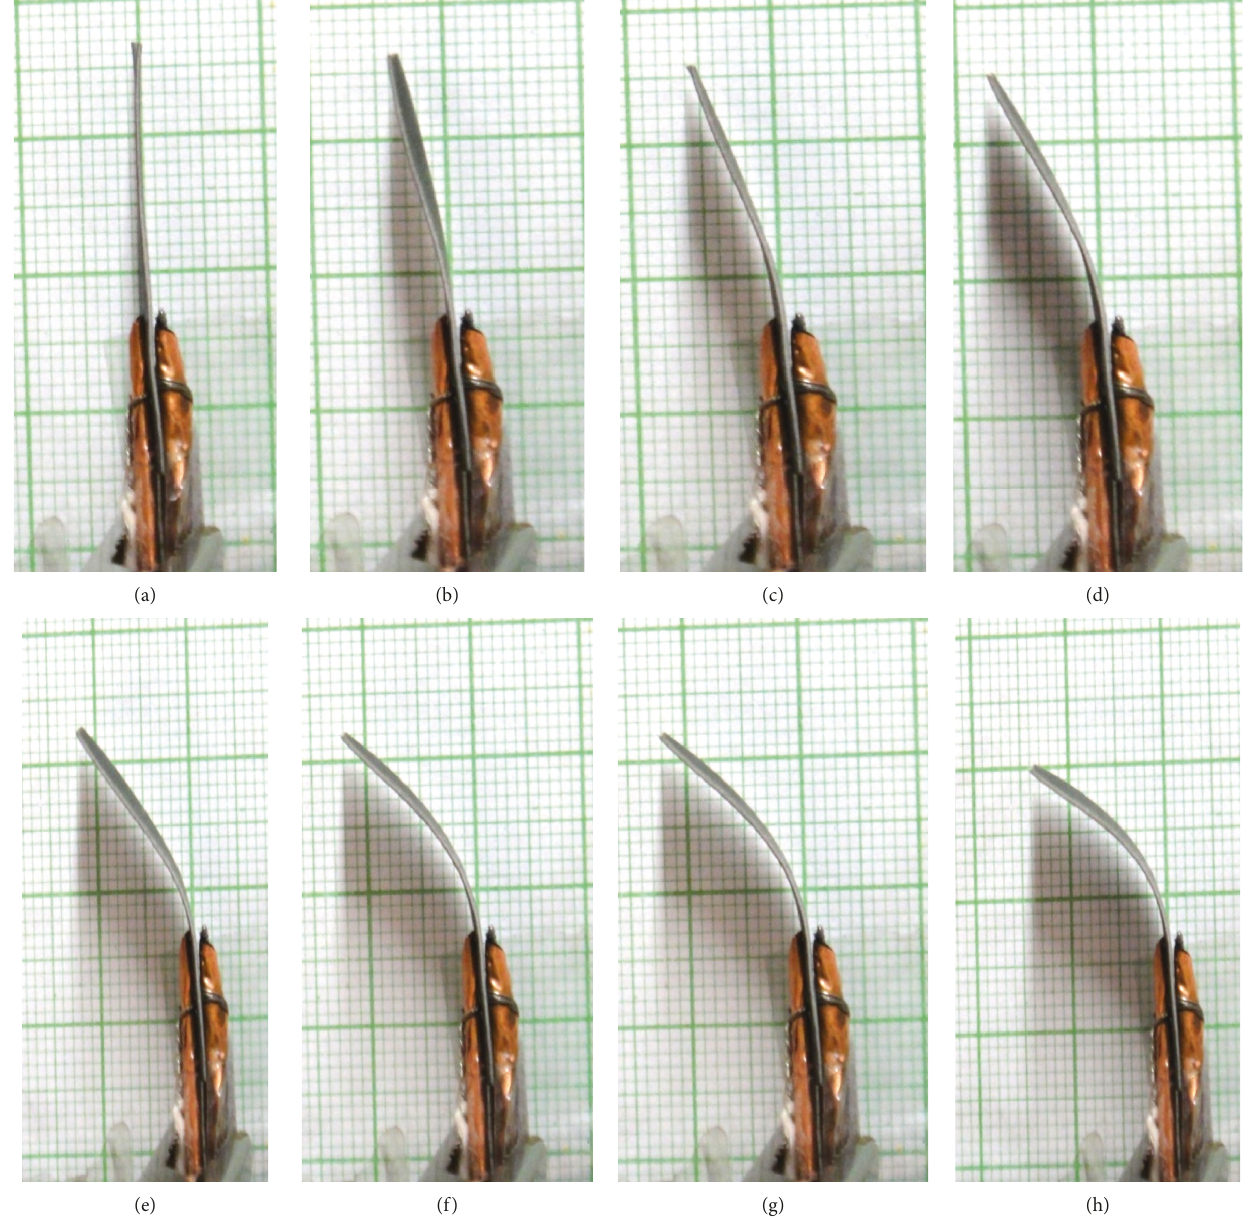
Figure 12: Experimental deflection response of PANI/PVC-PEDOT: PSS-ZrP at different voltages (0–3.5V): (a) 0V, (b) 0.5V, (c) 1.0V, (d) 1.5V, (e) 2.0 V, (f) 2.5V, (g) 3.0 V, and (h) 3.5 V.